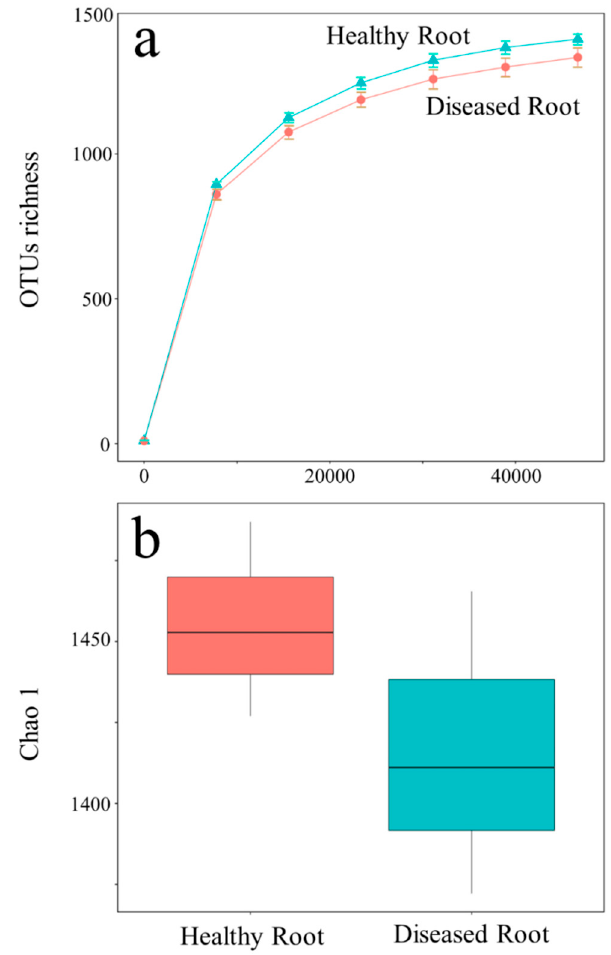
Figure 2. The rarefaction curve ( a ) and Chao 1 ( b ) α -diversity of the healthy and diseased cucumber roots.